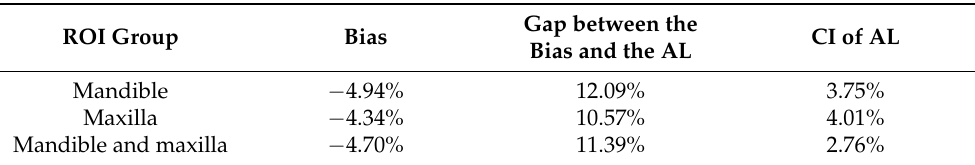
Table 3. Bias, gap between the bias and the agreement limit (AL), and the confidence interval (CI) of the AL of each ROI group. Gap between the ROI Group Bias CI of AL Bias and the AL Mandible − 4.94% 12.09% 3.75% Maxilla − 4.34% 10.57% 4.01% Mandible and maxilla − 4.70% 11.39%